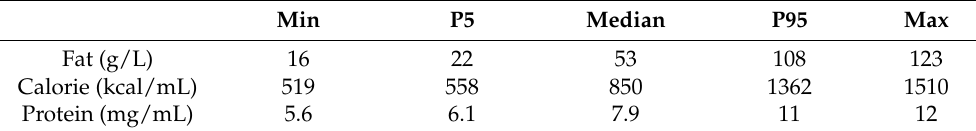
Table 5. Fat, calorie, and protein concentrations in human breast milk ( N = 132). Min P5 Median P95 Max Fat (g/L) 16 22 53 108 123 Calorie (kcal/mL) 519 558 850 1362 1510 Protein (mg/mL) 5.6 6.1 7.9 11